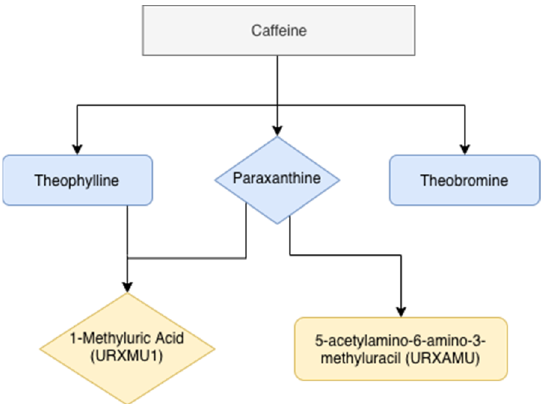
Figure 1. Main caffeine metabolites in humans (adapted from Nehlig et al. [10]).